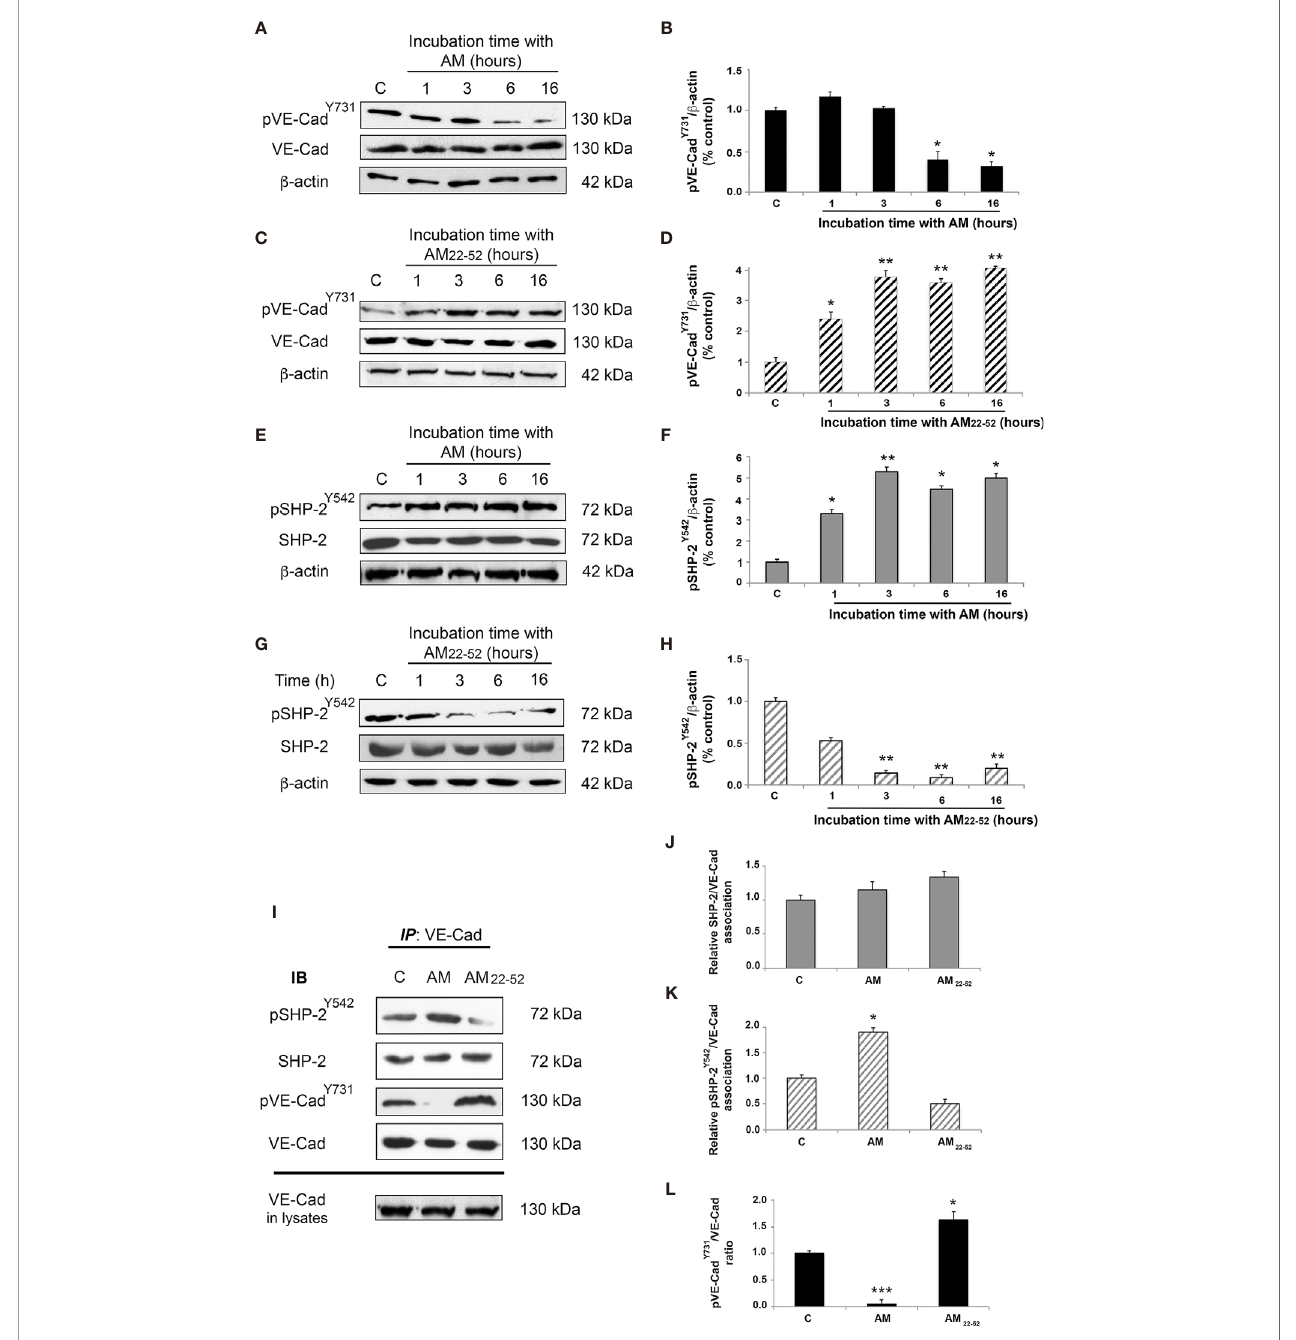
FIGURE 6 | AM regulates phosphorylation for VE-cadherin Y731 and SHP-2 Y542 in GBM-associated endothelial cells in vitro . (A, C, E, G) Total cell lysates prepared from GECs treated with AM (A, E) or AM 22-52 (C, G) were subjected to immunoblotting for VE-cadherin, pVE-cadherin Y731 , SHP-2; and pSHP-2 Y542 , as indicated on the left. AM (10 -9 M) decreases pVE-cadherin Y731 (A, B) and increases pSHP-2 Y542 (E, F) . On the other hand, AM 22-52 (10 -6 M) increases pVE-cadherin Y731 (C, D) and decreases pSHP-2 Y542 (G, H) in GECs in a time-dependent manner. Blotting for b -actin was used to control equal loading. (I) GECs were treated for 6 h with AM (10 -9 M), or AM 22-52 (10 -6 M), and protein extracts were subjected to immunoprecipitations for VE-cadherin, followed by immunoblotting for pSHP-2 Y542 , SHP-2, pVE-cadherin Y731 , and VE- cadherin as indicated on the left. (J) Nearly equal amounts of SHP-2 are associated to VE-cadherin independently of treatment. (K) Signi fi cant increases of phosphorylation for SHP-2 Y542 associated to VE-cadherin, subsequently to AM treatment. (L) Signi fi cant decreases and increases for pVE-cadherin Y731 after treatment with AM and AM 22-52, respectively. * p < 0.05; ** p < 0.01; *** p < 0.001. Each experiment is representative of three (B, D, F, H, J, K, L) independent experiments. Results are shown as means ±